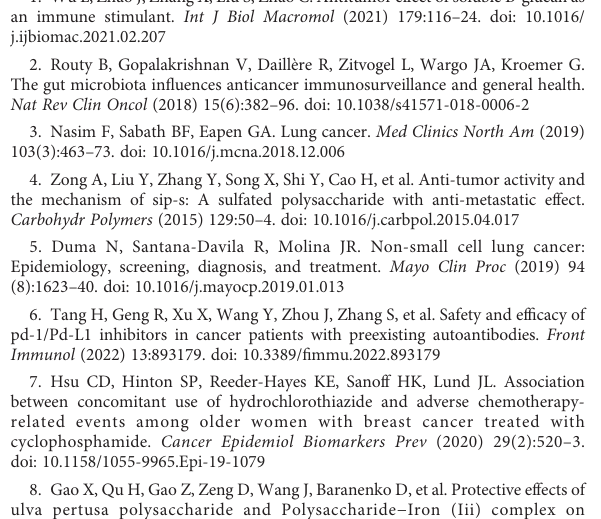
SUPPLEMENTARY FIGURE 1 Effects of THP on viability of RAW 264.7 and Lewis cells. Each value is presented as the mean ± SD. (A) RAW264.7. (B) Lewis cells. SUPPLEMENTARY FIGURE 2 Isolation and characterization of THP. (A) Anion-exchange chromatogram. (B) Gel chromatographic pro fi le on Superdex-200 column. (C) HPGPC chromatogram of THP. (D) FT-IR spectrum of THP. (E) GC-MS total ion chromatogram: (A) Monosaccharides standards, (B) THP, and (C) Reduction product of THP. (F) The effect of the dosage of cellulase, extraction time, extraction power, and the ratio of water to material on the extractionrate of THP. (G) Response surface plots of extraction rate of THP SUPPLEMENTARY FIGURE 3 EffectofTHPoncytokineandimmunoglobulinlevelsintheserumofLewis tumor-bearingmice.Eachvalueispresentedasthemean±SD. (A) IL-2. (B) TNF- a . (C) IFN- g . (D) IgG. (E) IgM. (F) IgA.*P<0.05, **P<0.01, ***P<0.001 versus Control; # P<0.05, ## P<0.01, ### P<0.001 versus